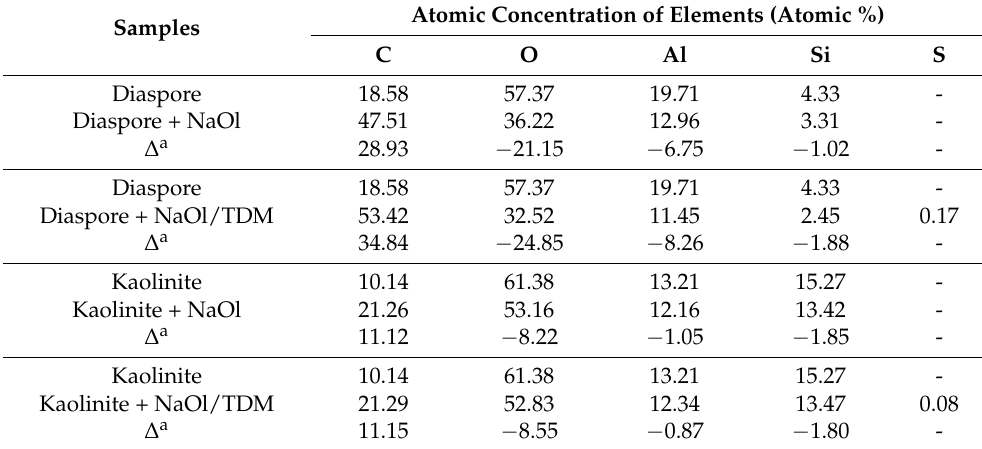
Table 3. Atomic concentration of elements for mineral interfaces, as determined by XPS at 283 K.